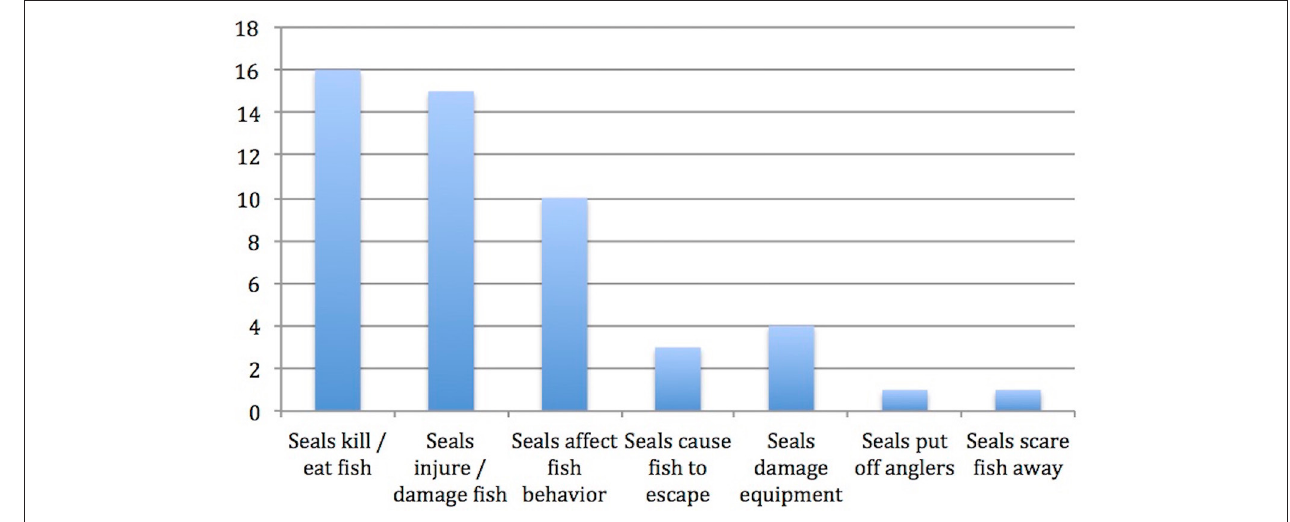
FIGURE 2 | Responses to Question 1 of License Holder Survey “What problems have you experienced with